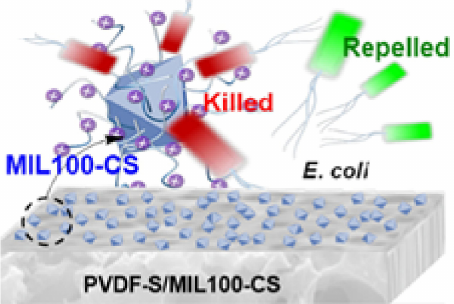
Figure 11. Antibacterial inhibition activity illustration of composite made of PVDF-S/MIL100-CS [29].